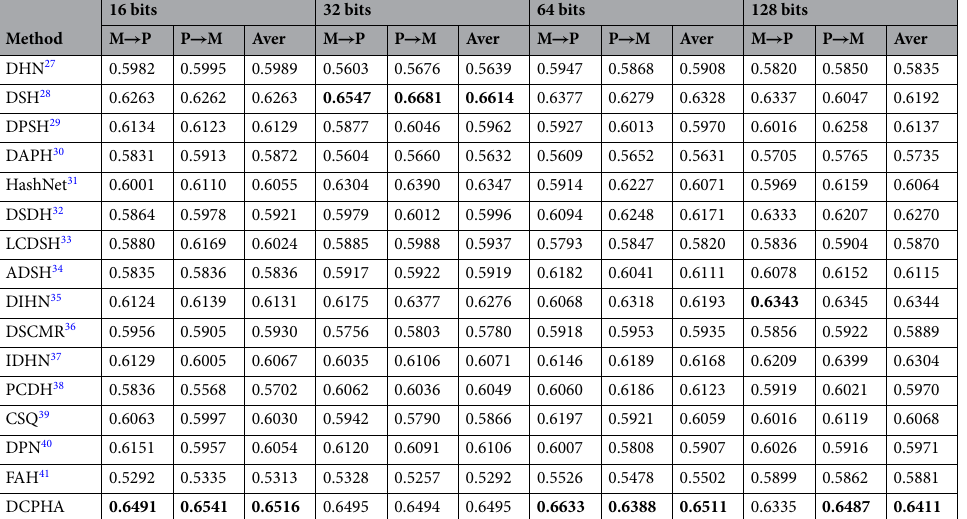
Table 3. The mAP scores of cross-modal retrieval on OASIS3 with different lengths of hash codes. Best Performance in